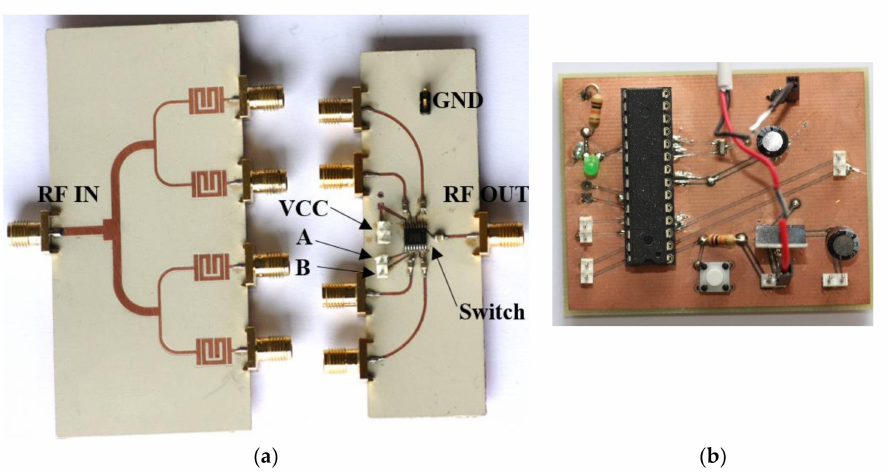
Figure 7. ( a ) Photograph of the power divider and switch; ( b ) photograph of the control